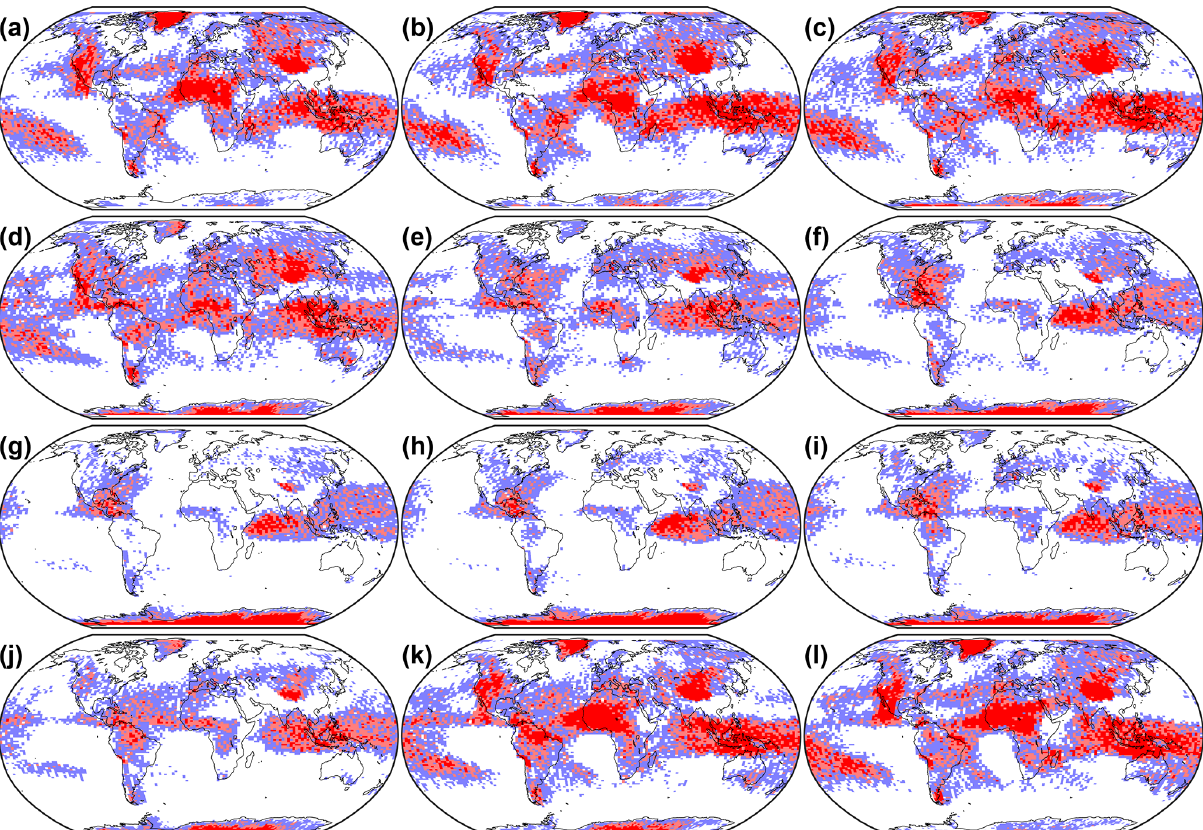
Figure A6. Same as Fig. 9a but for individual months: (a) January, (b) February, (c) March, (d) April, (e) May, (f) June, (g) July, (h) August, (i) September, (j) October, (k) November, and (l)